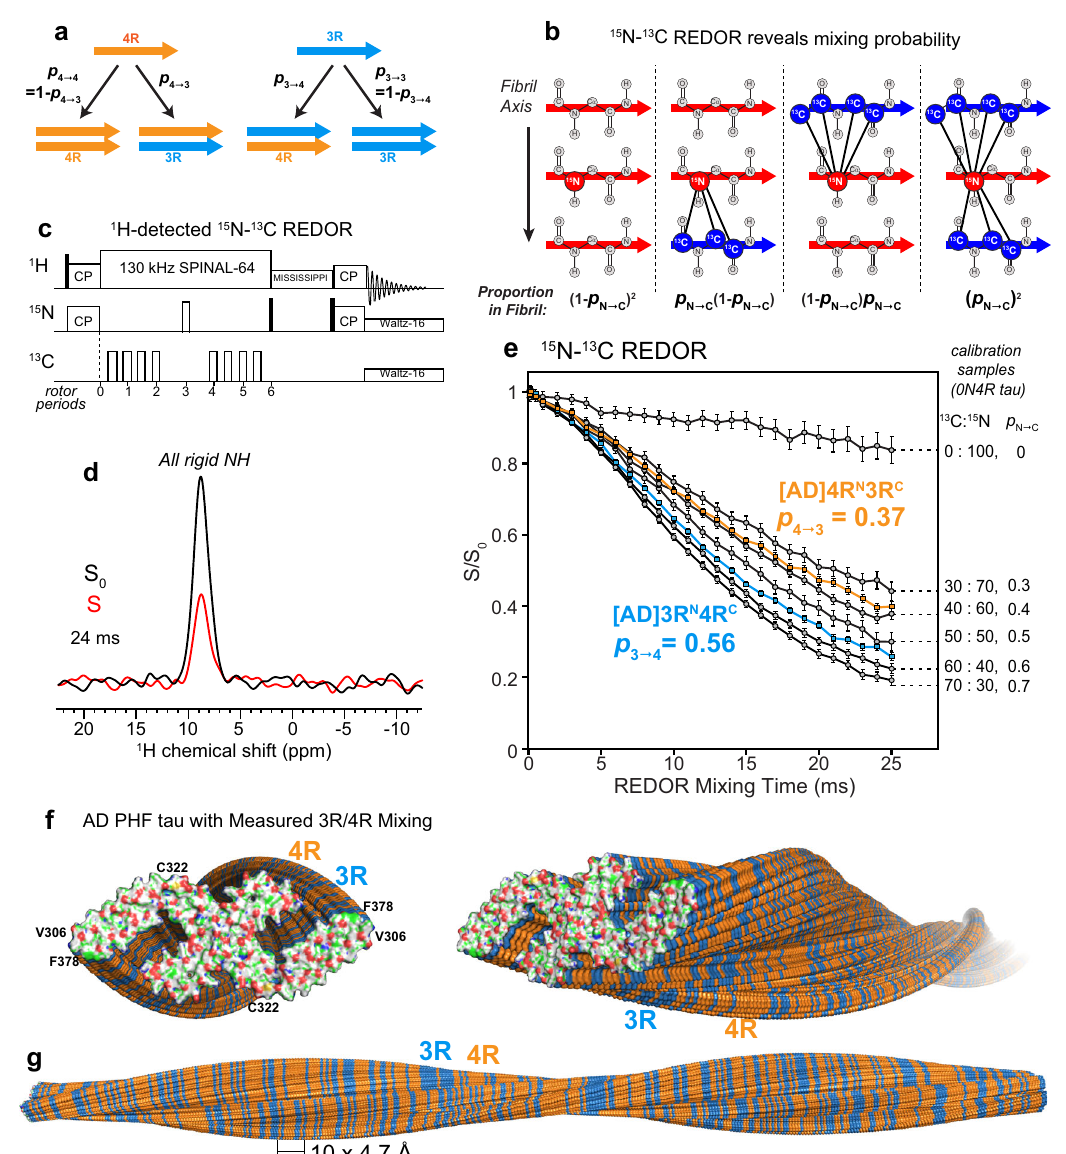
Fig. 3 15 N – 13 C REDOR NMR reveals the tau isoform mixing pattern in Alzheimer ’ s disease brain tau fi laments. a Schematic of four possible isoform combinations of two hydrogen-bonded tau molecules and their probabilities. b Diagram of four possible nearest neighbors of an 15 N-labeled tau and their probabilities in a fi bril. The probability that an 15 N-labeled tau is followed by a 13 C-labeled tau is denoted by p N → C . Larger p N → C values increase the intermolecular 15 N – 13 C dipolar dephasing, which is manifested as lower REDOR S / S 0 ratios. c Pulse sequence for the 1 H-detected 15 N – 13 C REDOR experiment. d A representative pair of the REDOR spectra, showing the total intensities of all rigid protein amides in the absence ( S 0 ) and presence ( S ) of 13 C dephasing pulses. This spectrum was measured on [AD]4R N 3R C #2 with a mixing time of 24 ms under 20 kHz MAS. e Measured 1 H-detected 15 N – 13 C REDOR decay curves. The REDOR data of mixtures of 13 C, 2 H-labeled 0N4R tau and 15 N, 2 H-labeled 0N4R tau serve as calibrations (gray) for quantifying p 13 C-labeled protein in the mixture. The REDOR data of AD-seeded 4R N 3R C indicate a probability p N → C , which is equal to the fraction of 4 → 3 of 0.37, while the data of AD-seeded 3R N 4R C give a probability p 3 → 4 of 0.56. Each curve represents the average of two independently fi brillized samples. Error bars represent the propagated uncertainty from the spectral signal-to-noise ratio (one standard deviation). f , g Mixing of 4R (orange) and 3R (blue) tau in an AD PHF fi bril (PDB: 5O3L). Tau isoforms along the fi bril axis were simulated using the measured mixing probabilities. The simulations were done independently for each of the two proto fi laments. f End view (left) and oblique view (right) of the PHF tau fi laments. The terminal monomers ’ atoms are colored as H — white, C — green, N — blue, O — red, and S — yellow. g Sideview of the PHF tau fi bril, showing a pair of proto fi laments containing 360 monomers each, with a fi lament length of ~170